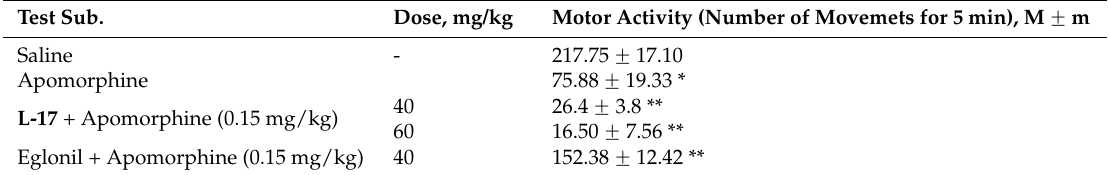
Table 3. Evaluation of apomorphine-induced hypoactivity following administration of compound L-17 . Test